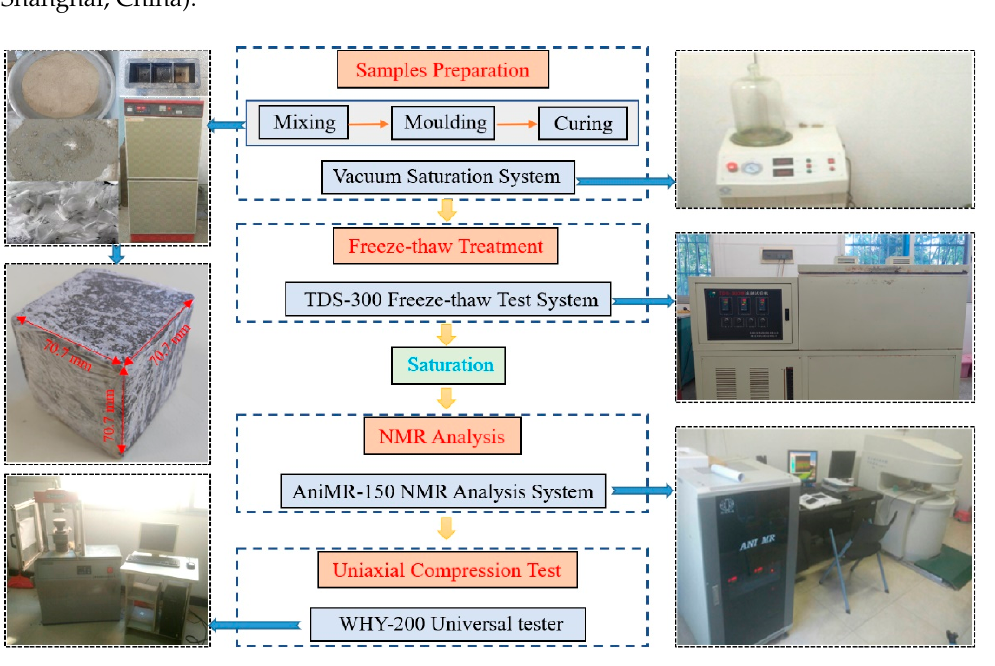
Figure 1. Experimental procedures and